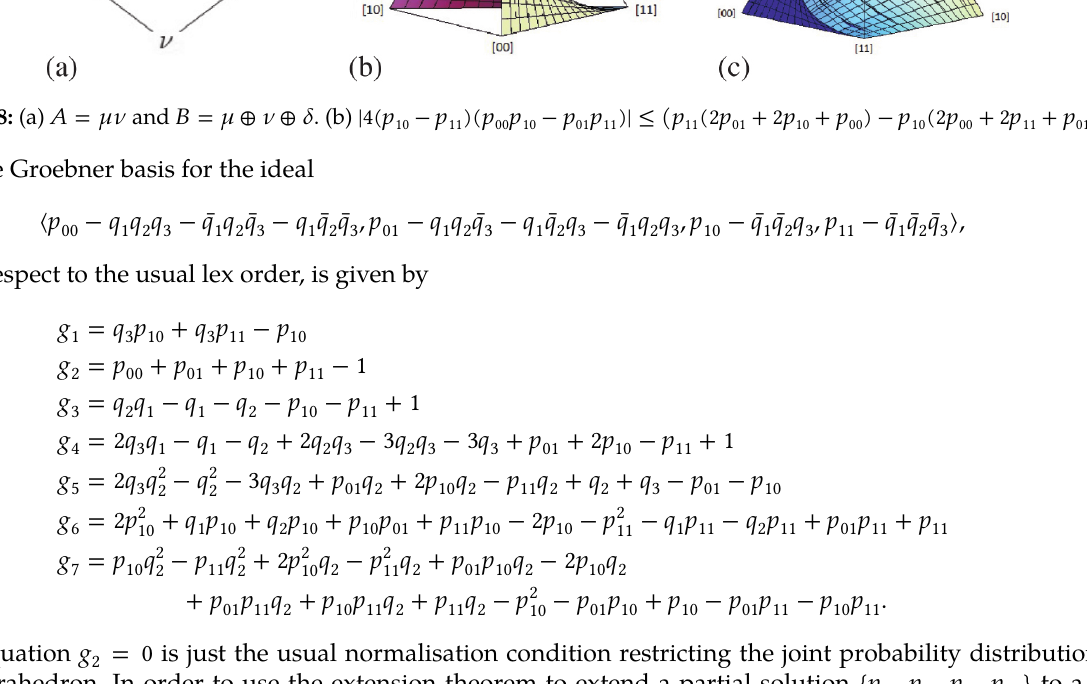
( 2 u + 2 u + u ) − u ( 2 u + 2 u + u )  2 . 11 01 10 00 10 00 11 01